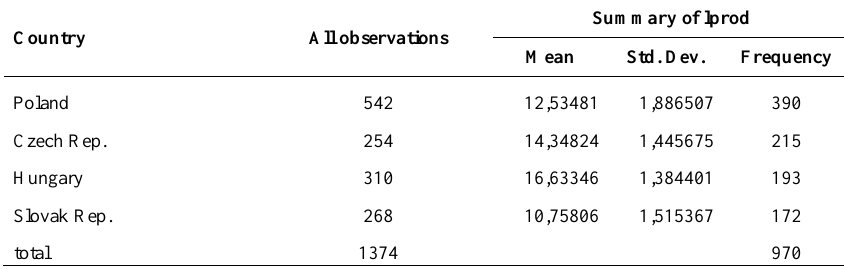
Table 5. The list of analyzed countries and the number of observations on labor